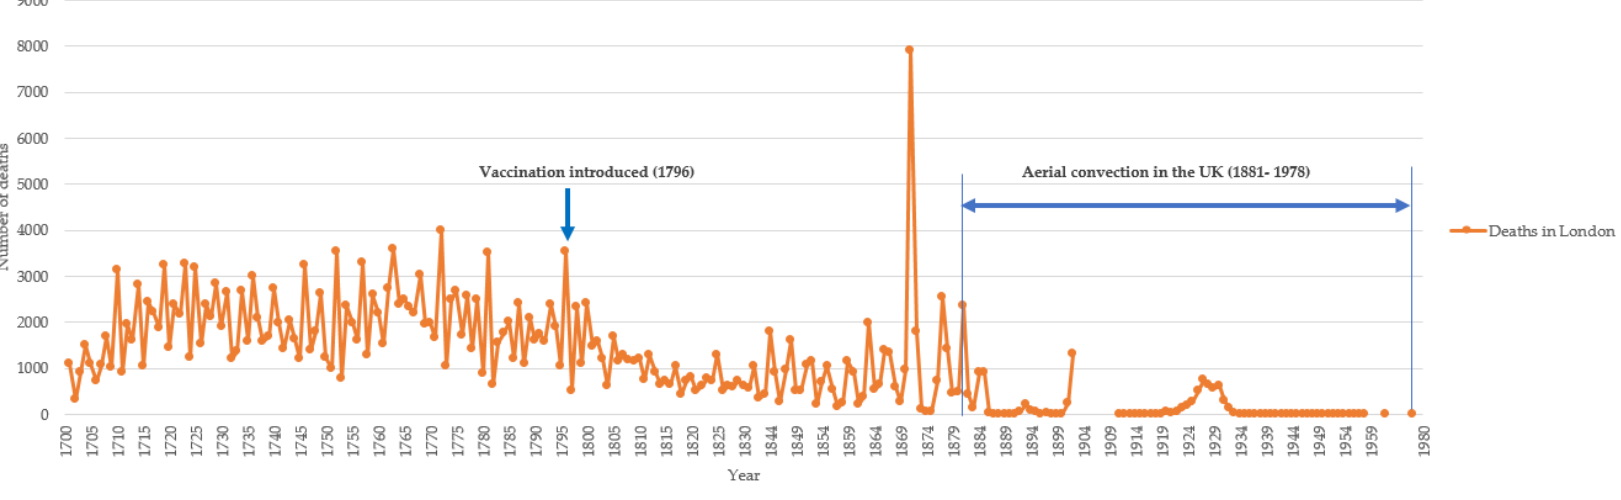
Figure 3. Number of smallpox deaths 1700 – 1980, London — period of observation of aerial convection shown in two-sided horizontal arrow.